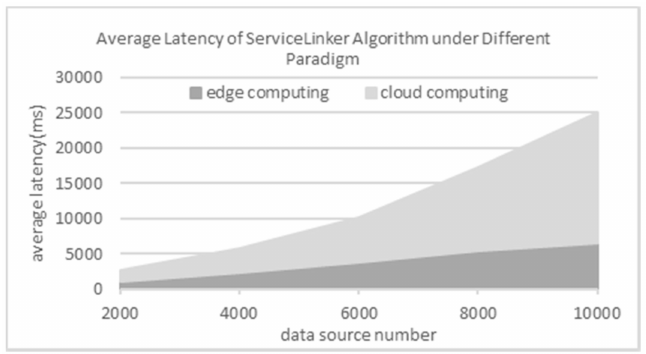
Figure 9. Average latency under edge computing and cloud computing on different synthetic